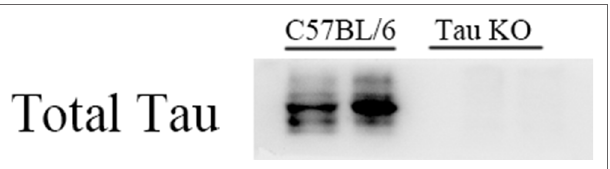
FIGURE 1 | Tau knockout (KO) mice did not express Tau